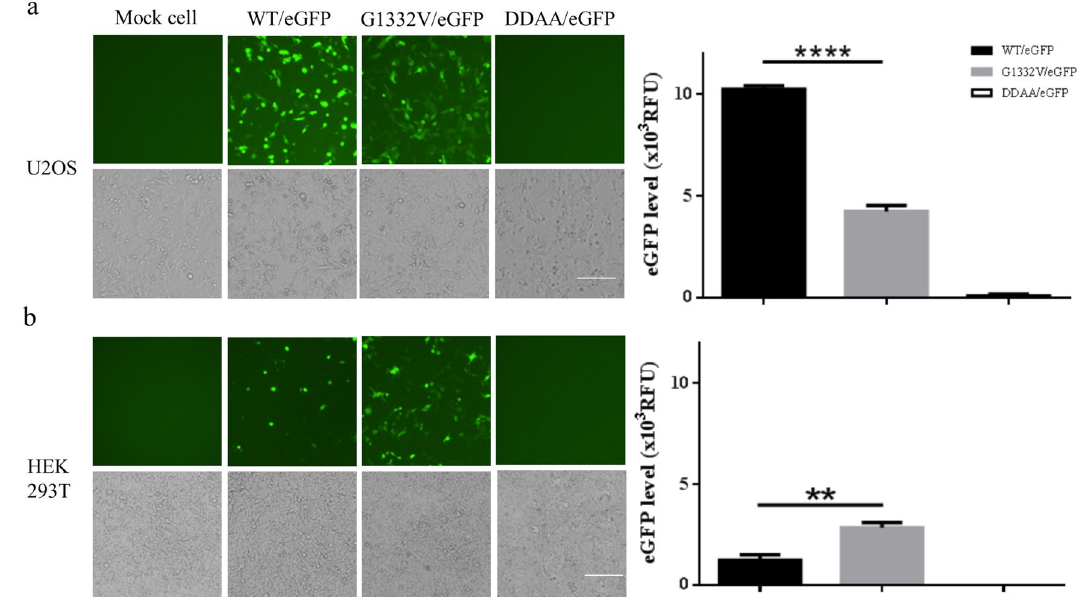
Figure 7. Autonomous CHIKV replicon-mediated eGFP expression of replicon variants in mammalian cell lines. U2OS ( a ) or HEK293T ( b ) cells were transduced in triplicate using either WT/eGFP, G1332V/eGFP, or DDAA/eGFP at an indicated MOI of 10. At 2 dpt, eGFP-expressing cells were photographed using green (upper panels) or bright field (lower panels) filters. Expression levels of eGFP were quantified (right part). Error bars represent the standard deviation. The statistical significance between WT/eGFP and G1332V/eGFP was analyzed using a Student’s t-test (** p < 0.01 and **** p < 0.0001).